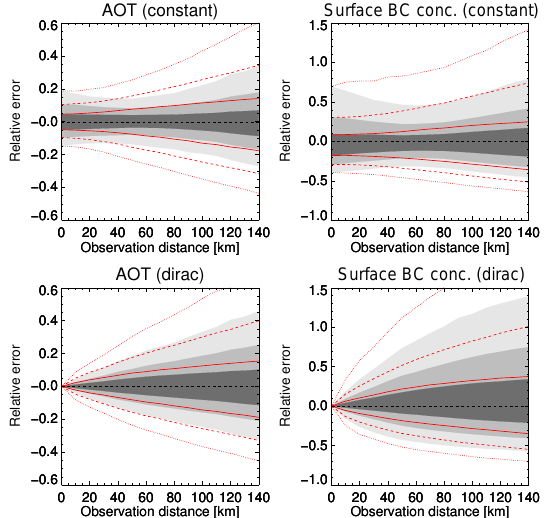
Figure 18. Relative spatial sampling error (monthly data) for four randomly distributed sites as a function of distance to the grid point, assuming two different weighting functions. The red lines indicate the errors for a single site (see also Fig. 14). Results from WRF- Chem MADE over W. Europe. Further explanation in Sect. 3.2.